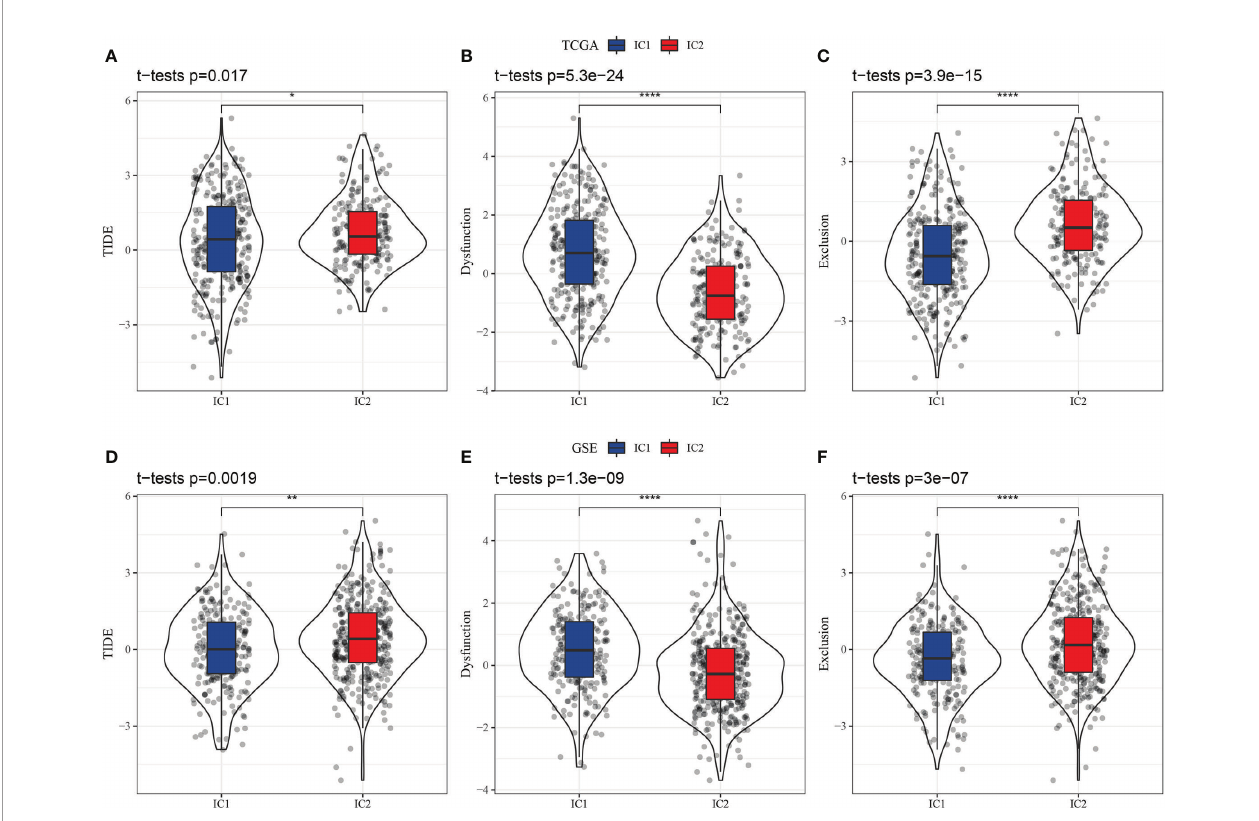
FIGURE 7 | Differential analysis of T cell dysfunction and exclusion (TIDE) between molecular subtypes in two datasets (TCGA-LUAD and GSE-LUAD). (A) TIDE scores in TCGA-LUAD samples. (B) T cell dysfunction scores in TCGA-LUAD samples. (C) T cell rejection scores in TCGA-LUAD samples. (D) TIDE scores in GSE- LUAD samples. (E) T cell dysfunction scores in GSE-LUAD samples. (F) T cell rejection scores in GSE-LUAD samples. *p < 0.05; **p < 0.01, ****p <